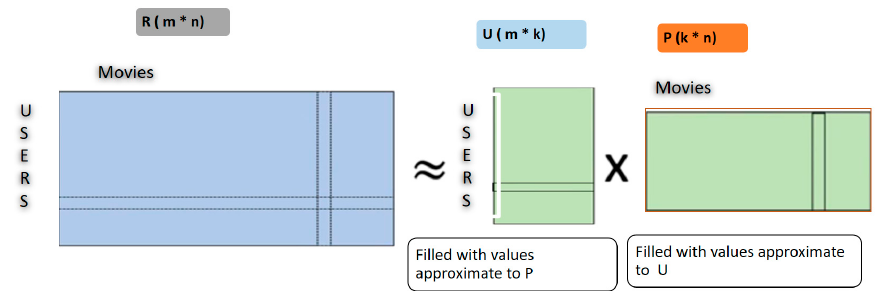
Figure 5. Working diagram of matrix-factorization method used in ALS.